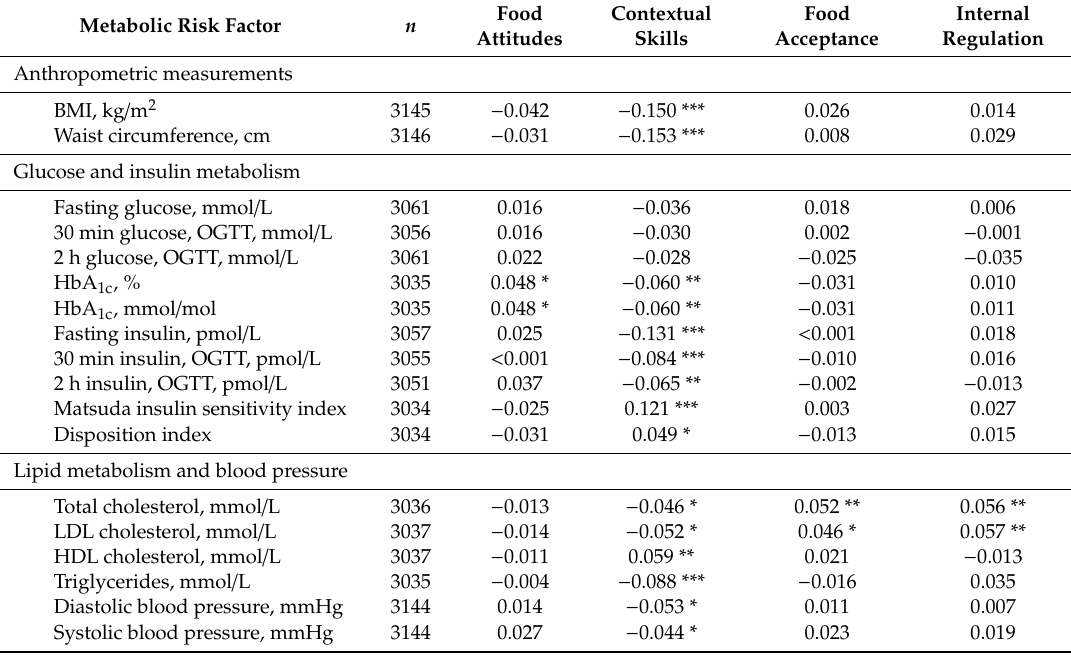
Table 4. Associations of eating competence subcomponents: food attitudes, contextual skills, food acceptance and internal regulation with type 2 diabetes metabolic risk factors. Metabolic Risk Factor n